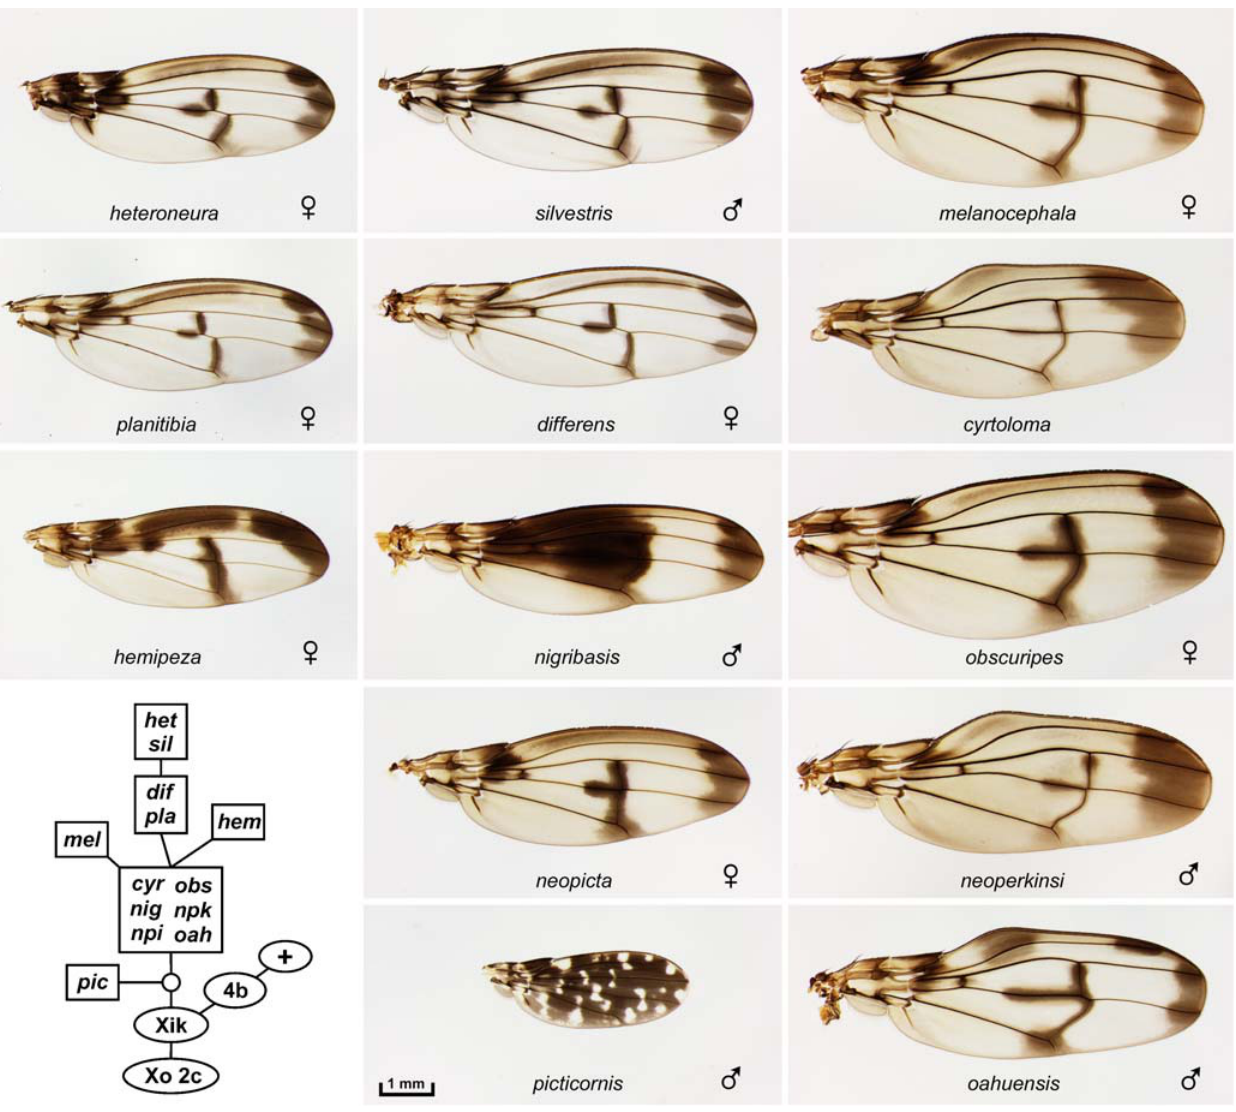
Figure 3. The planitibiasubgroup of picture wing species [7]. The planitibia complex: differens, hemipeza, heteroneura, planitibia , and silvestris . The neopicta complex: neopicta ( npi ) and nigribasis . The cyrtoloma complex (right column): cyrtoloma, melanocephala, neoperkinsi ( npk ), oahuensis , and obscuripes . The picticornis complex: picticornis . Inset, chromosome inversion-based lineage for the species shown (see text). The six species in the large box arose from an ancestral population that was polymorphic for the inversions that now differ among these species; see Carson [41] for details.